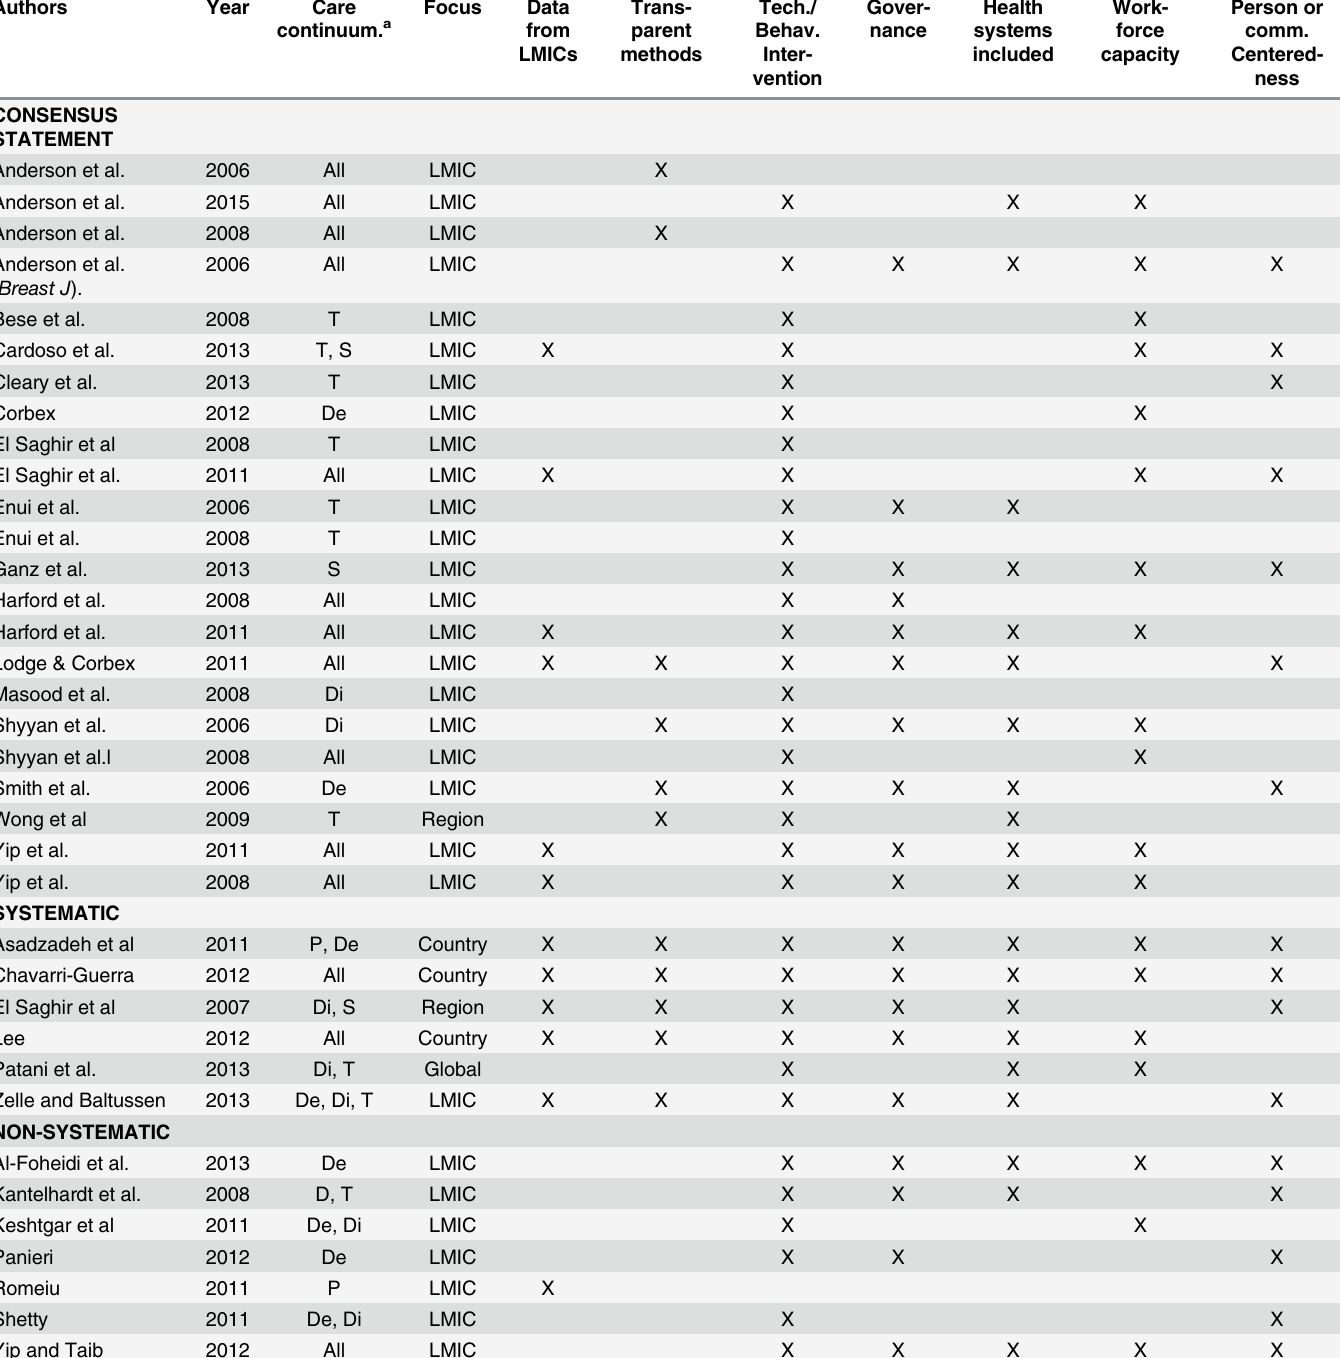
Table 5. Reviews of breast cancer in low- and middle-income countries